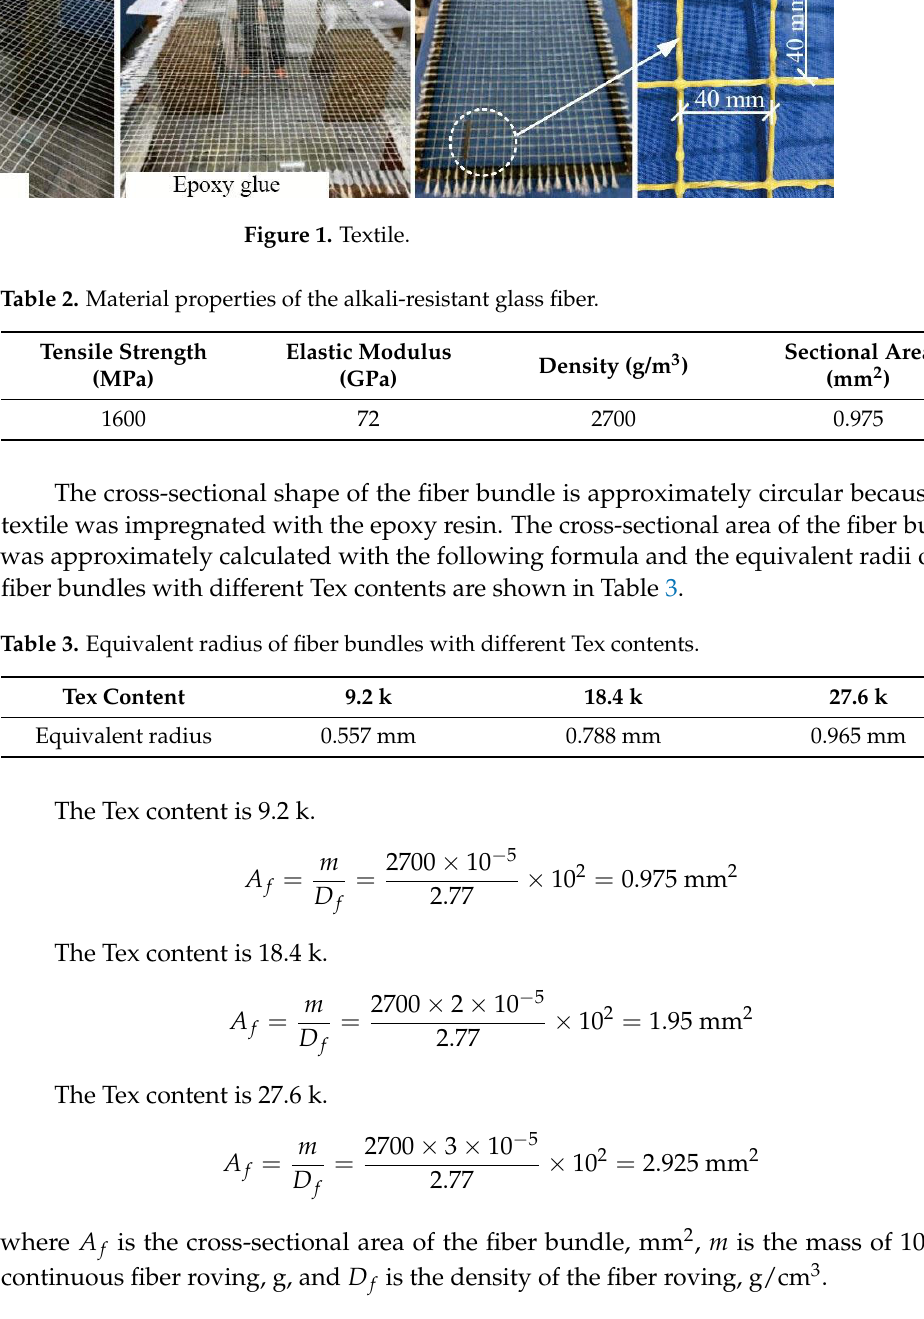
Table 4. Differences of specimens.